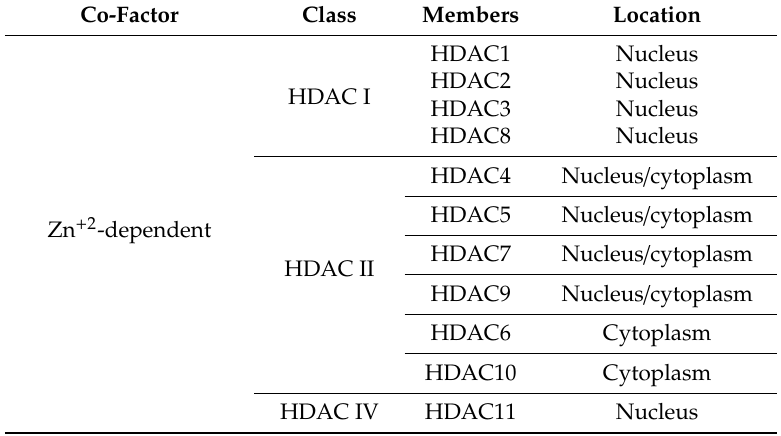
Figure 1. Acetylation and deacetylation of nucleosomal histones and other cellular proteins that play an important role in the modulation of chromatin arrangement and gene expression, as well as in the regulation of protein stability and cellular function. Histone acetyltransferases (HATs) and histone deacetylases (HDACs) are two contrasting classes of enzymes that closely regulate histone acetylation and deacetylation. Table 1. Di ff erent classes of HDACs, their co-factors, and their cellular